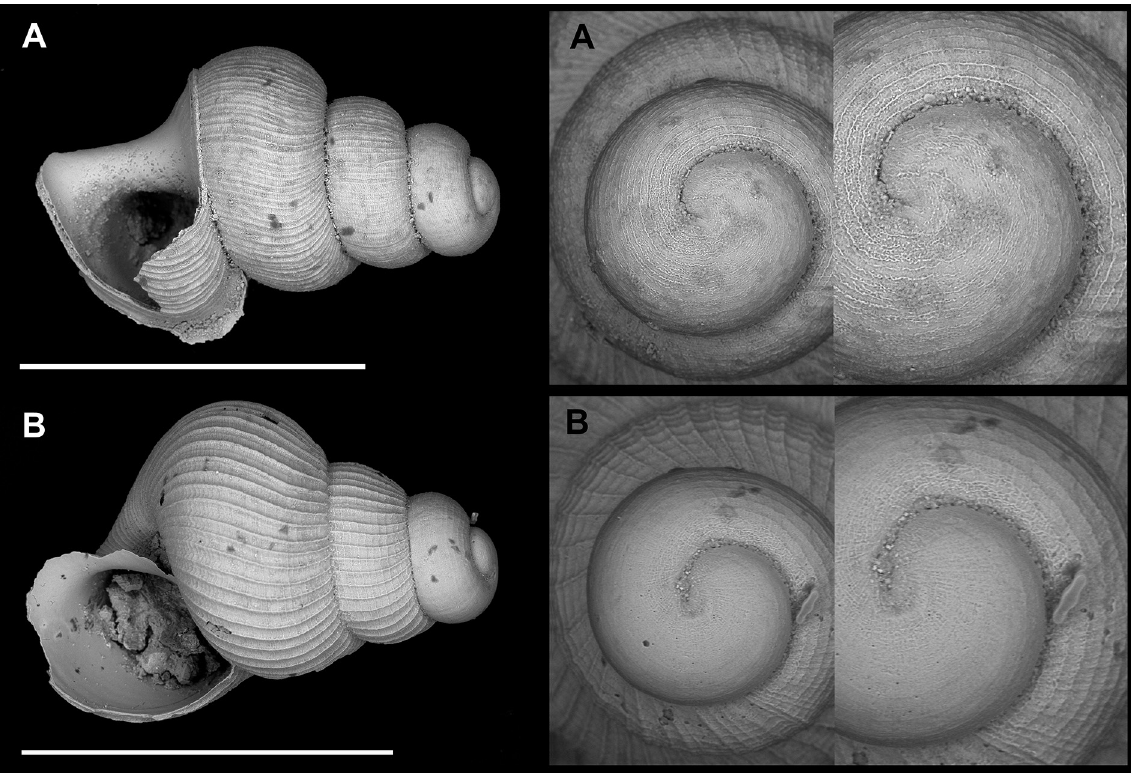
Fig. 11. A . Plagigeyeria ozimeci sp. nov., Vitina, Vrilo Vrioštica, paratype SBMNH 626440. B . Plagigeyeria lewarnei sp. nov., spring Tučevac in Trebinje, SBMNH 626406. Scale bars = 1 mm (SEM SBMNH Vanessa